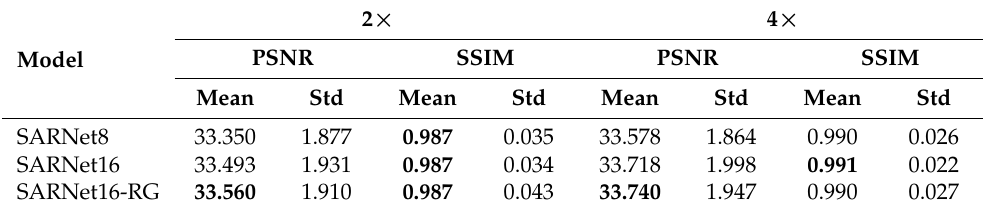
Table 4. PSNR and SSIM metrics obtained for the test set with different number of RCABs.